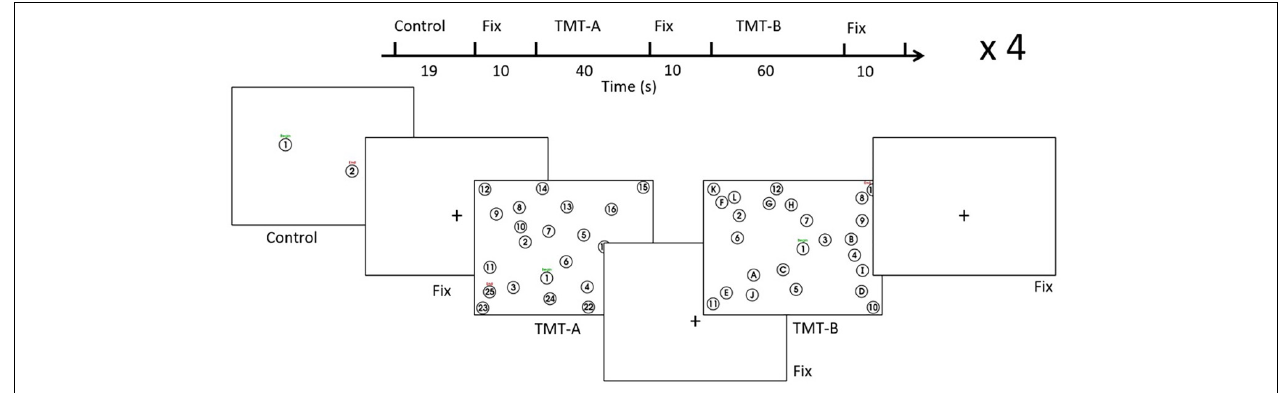
FIGURE 1 | Task design for the EEG experiment. See text for details. Fix = fixation, TMT = Trail Making Test.